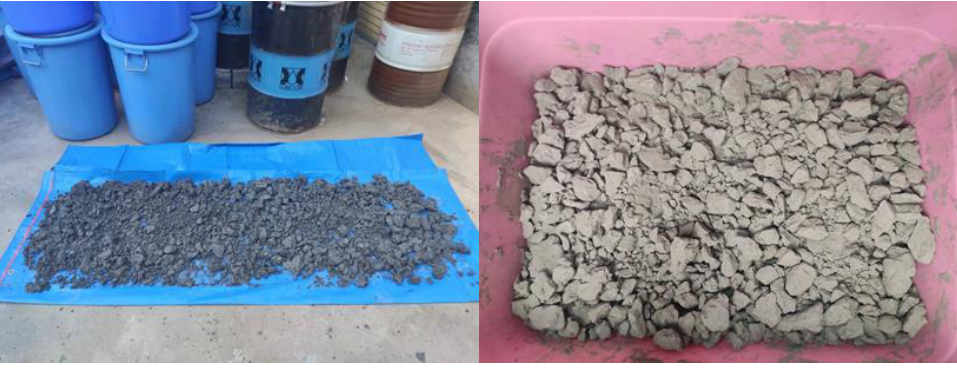
Table 1. Basic properties of silty clay in the ④ layer in Shanghai [33].